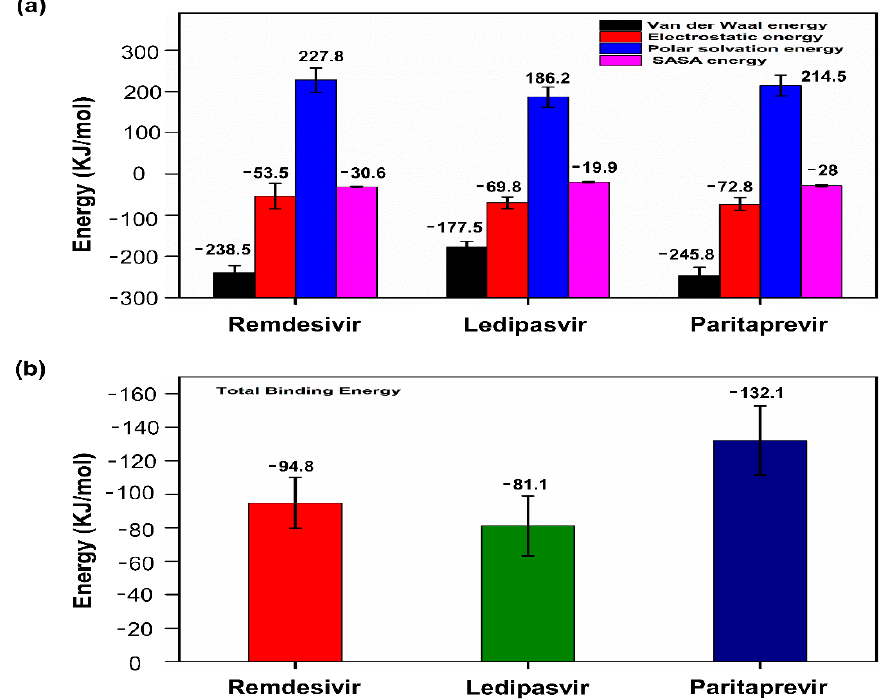
Figure 7. MM-PBSA binding free energy calculation. ( a ) Representative contributions of each energy component for RdRp with the selected drugs (remdesivir, ledipasvir, and paritaprevir). ( b ) The total binding free energy for RdRp in complex with the selected drugs.